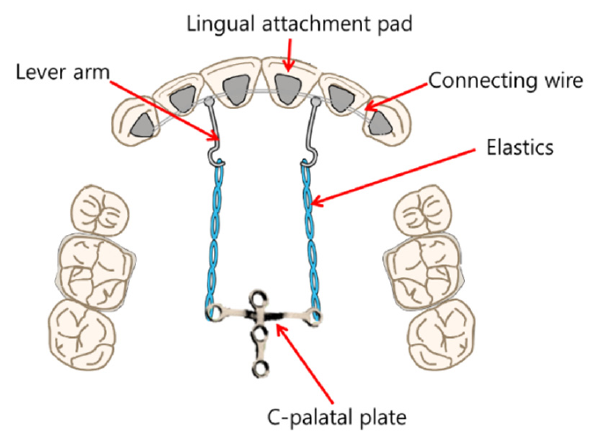
Figure 1. Schematic representation of C-lingual retractor (CLR).